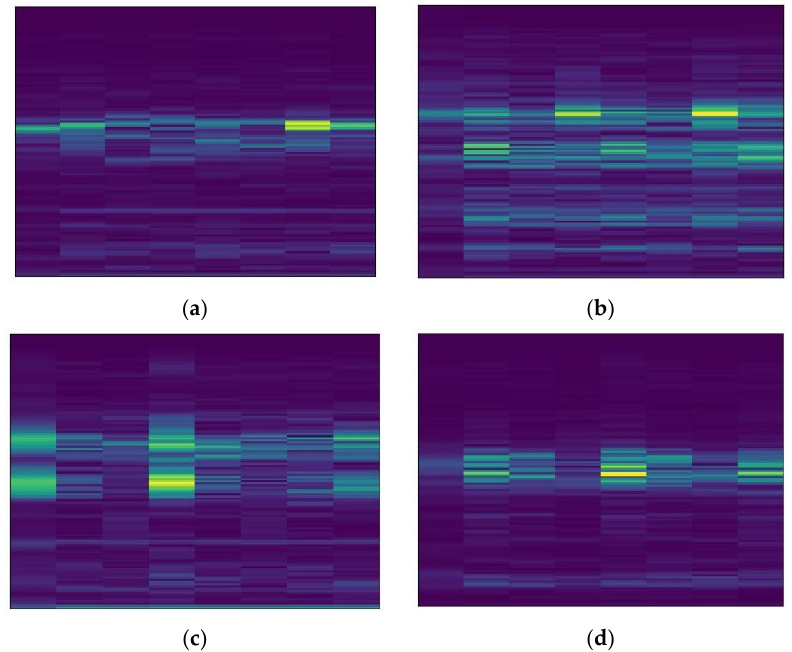
Figure 6. Spectrograms of 10 different label samples in CWRU domain A ( a ) NO, ( b ) IF07, ( c ) OF07, ( d ) RF07. Table 2. Sample configuration information table in each domain.